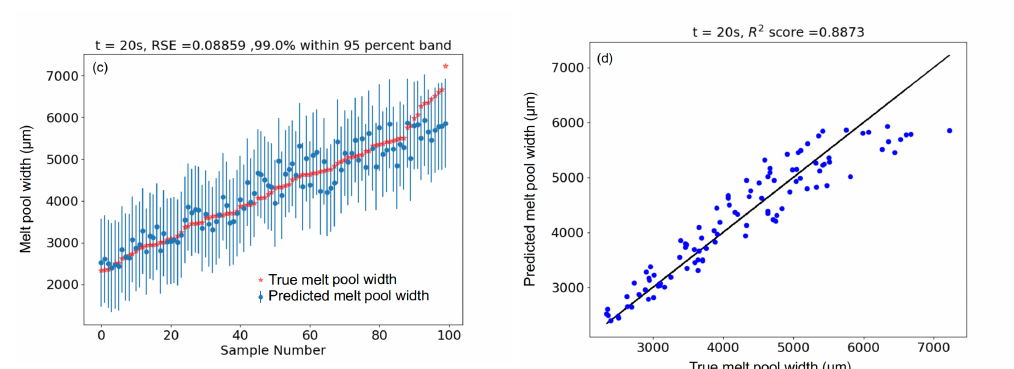
Figure 10. Melt pool depth and width prediction performance at 20 s with a training set size of 20 samples. ( a , b ) Probabilistic prediction of depth and corresponding parity plot. ( c , d ) Probabilistic prediction of width and corresponding parity plot. Samples arranged in ascending order of the true values in panels ( a , c ). Predicted values at the points of query are represented as follows; GP mean by blue dots and ± 2 σ bands by vertical bars, where σ is the standard deviation of the GP’s posterior prediction at a query point. Red stars indicate the true value of the melt pool depth at those